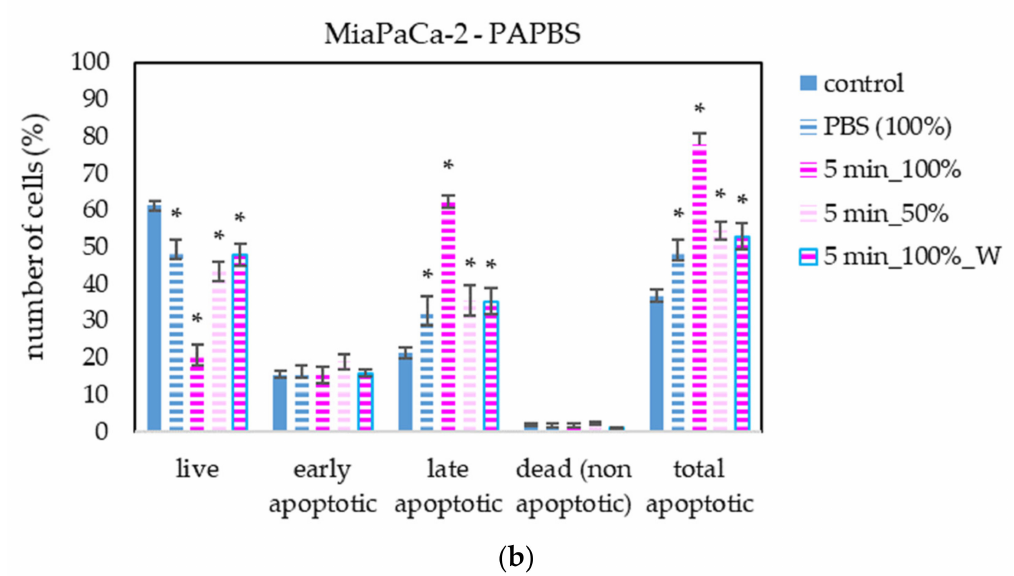
Figure 9. The effect of PAL on apoptosis induction in pancreatic cancer cells MiaPaCa-2, measured 24 h after PAL application. Plasma-activated medium—PAM ( a ) or plasma-activated PBS—PAPBS ( b ) activated for 5 min in 100% or 50% concentration were used. Time of PAL action was 24 h (without blue frames) or 30 min, after which PAL were replaced with untreated medium (“washing”, W, blue frames). The significant results ( p < 0.05) are marked with *. Significance of 100% PAPBS was tested compared to cells in 100% PBS, significance of other samples was tested compared to control.